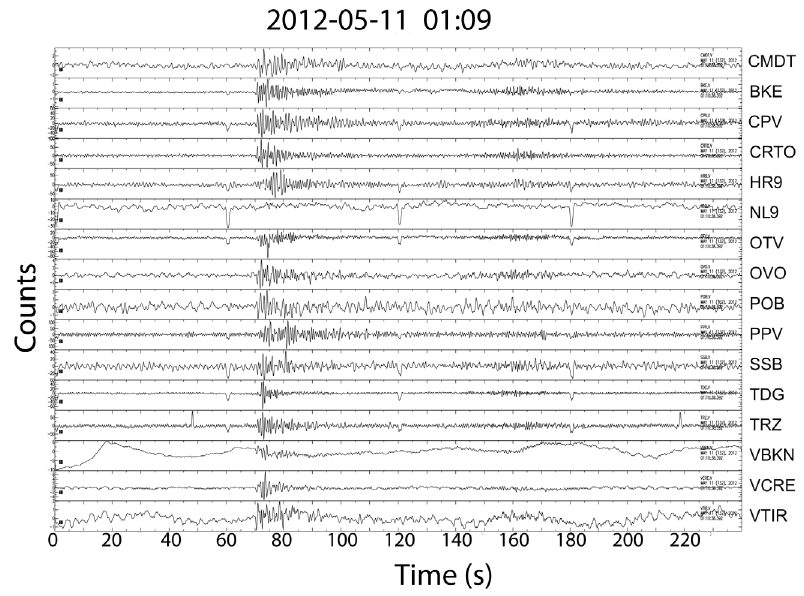
Figure 9. Traces of the very-low-frequency earthquake recorded by the seismic network of Mt. Vesuvius on May 11, 2012, at 01:09 UTC. The figure shows only the vertical components.